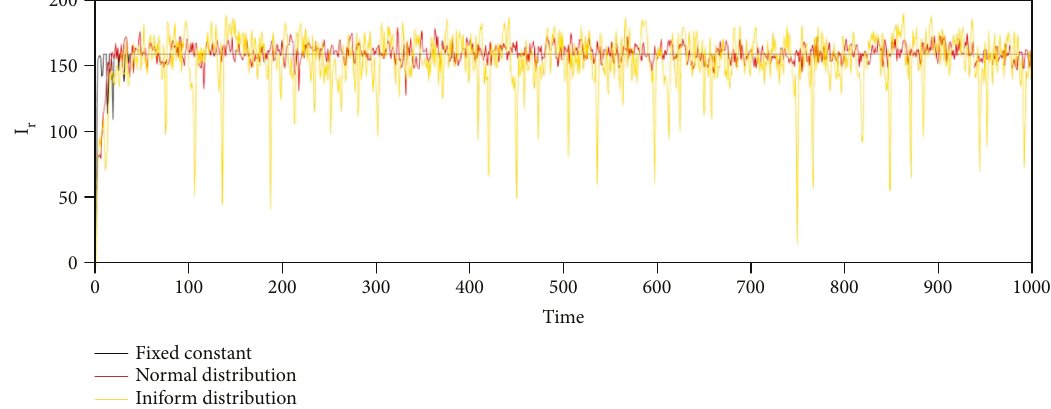
Figure 7: Retailers ’ initial inventory changes in a stable state under three demand scenarios.